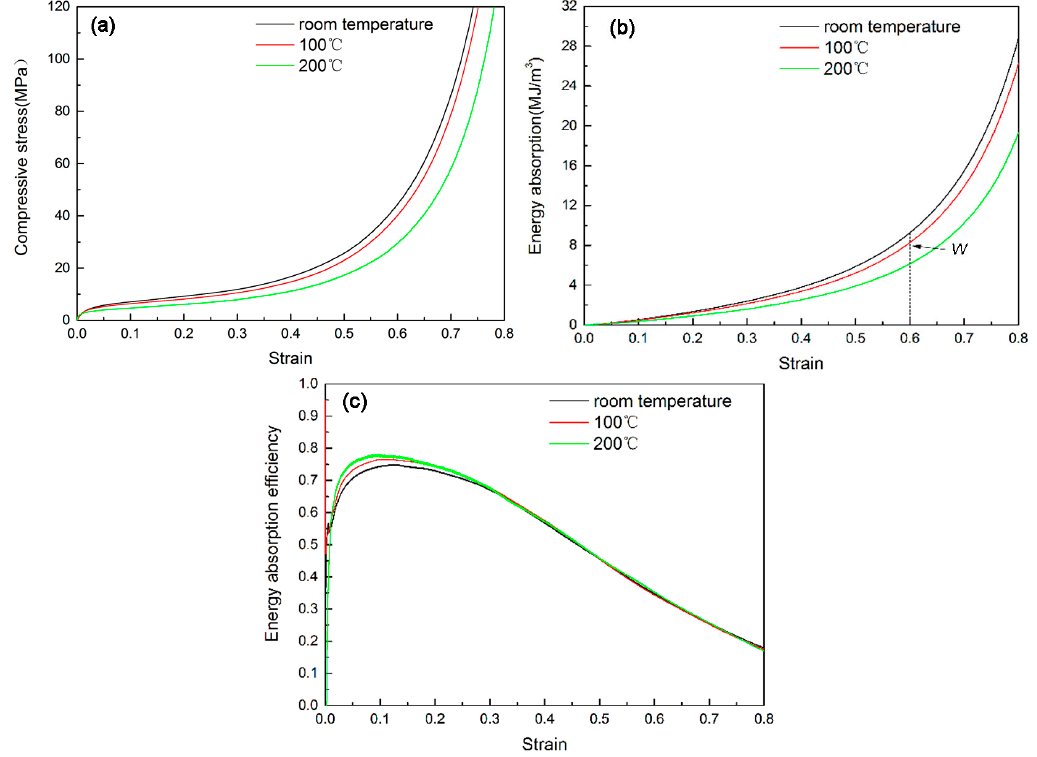
Figure 8. The compressive properties of the as-received foam at different temperatures: ( a ) compressive curves; ( b ) energy absorption; and ( c ) energy absorption efficiency.